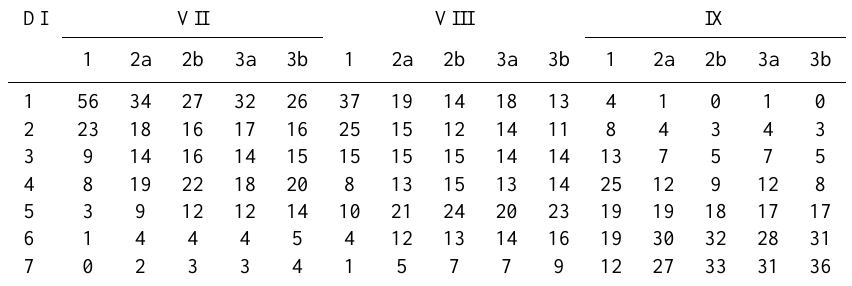
Note. DI is damage index.